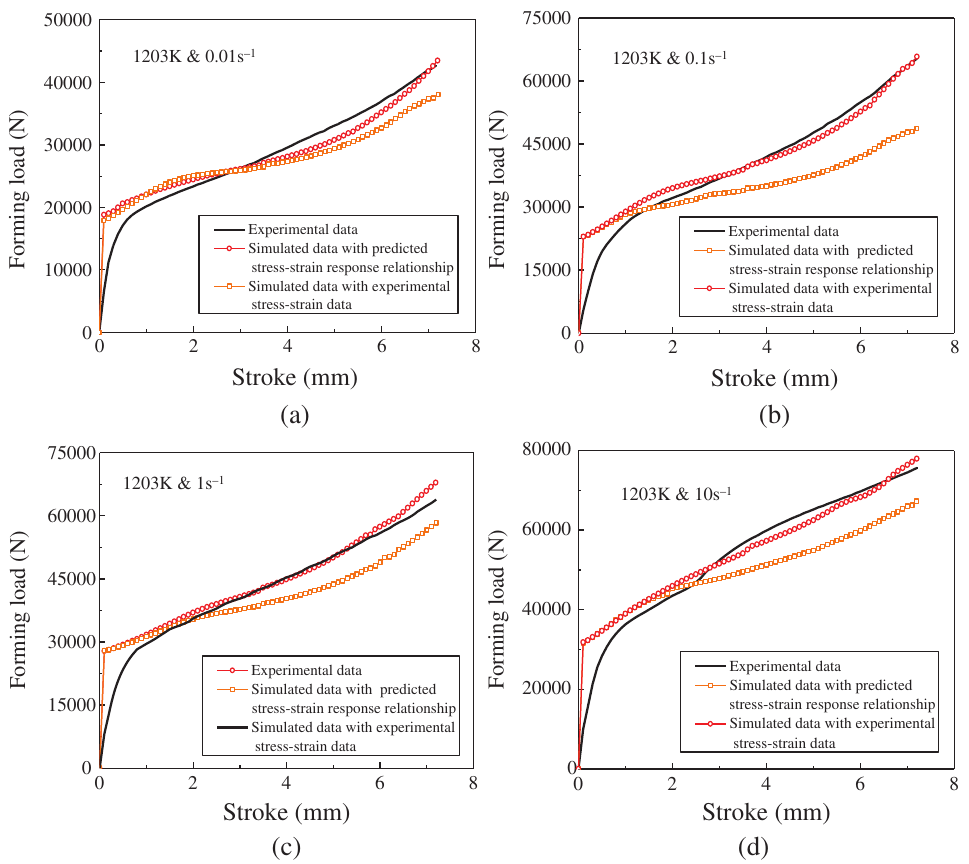
Figure 13: Comparisons between the predicted and experimental stroke-load curves under the temperature of 1203K and strain rates of (a) 0.01s − 1 , (b) 0.1s − 1 , (c) 1s − 1 and (d) 10s − 1